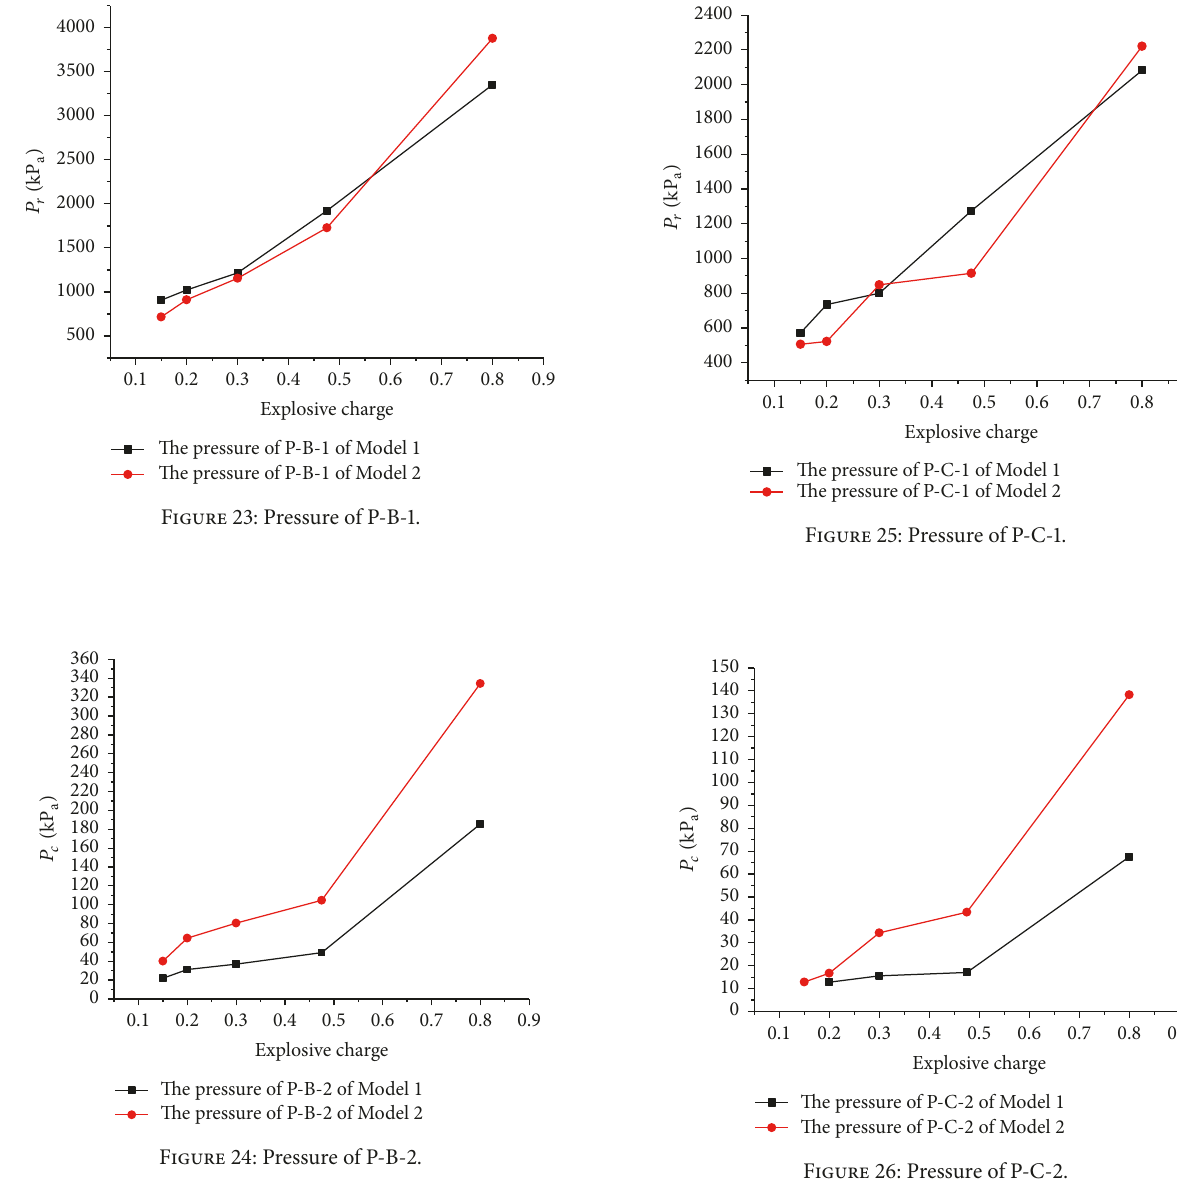
smaller than Model 2 at the same measurement point. Thus, the energy-dissipating capacity of Model 1 was better than Model